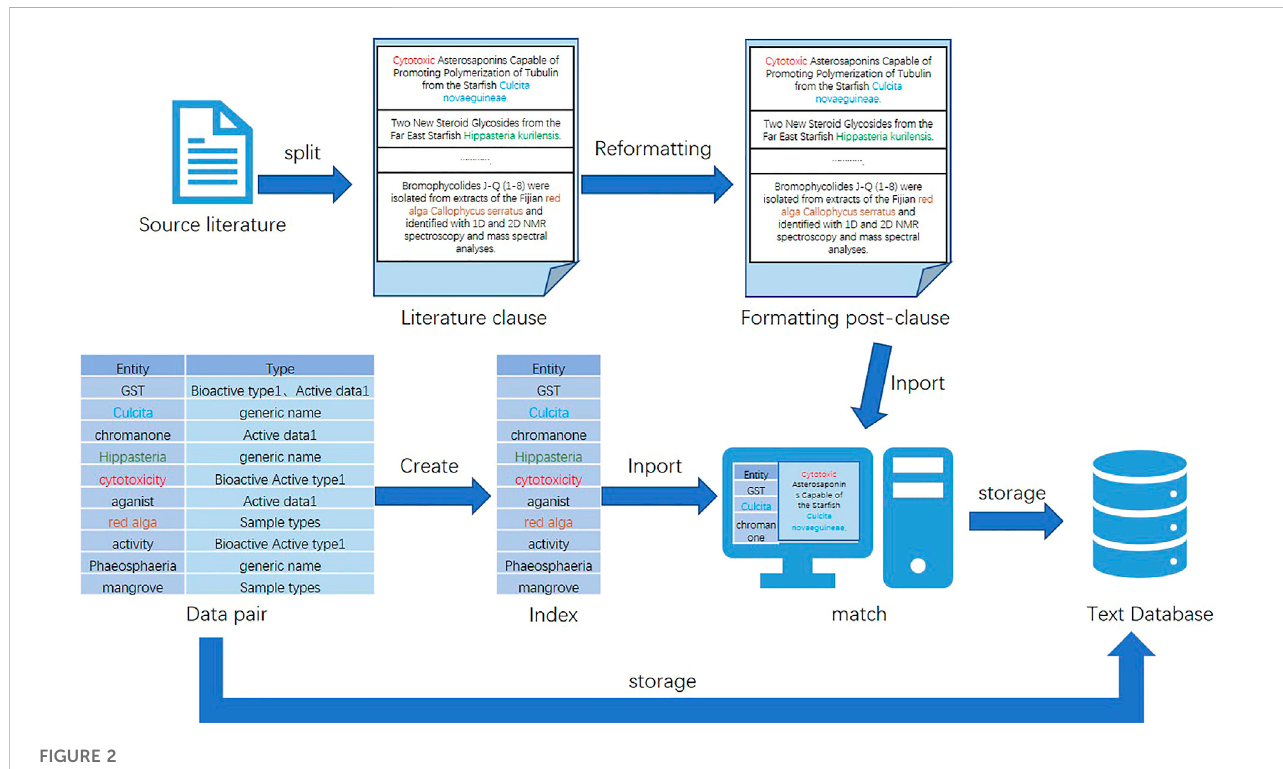
FIGURE 2 Dataset preparation